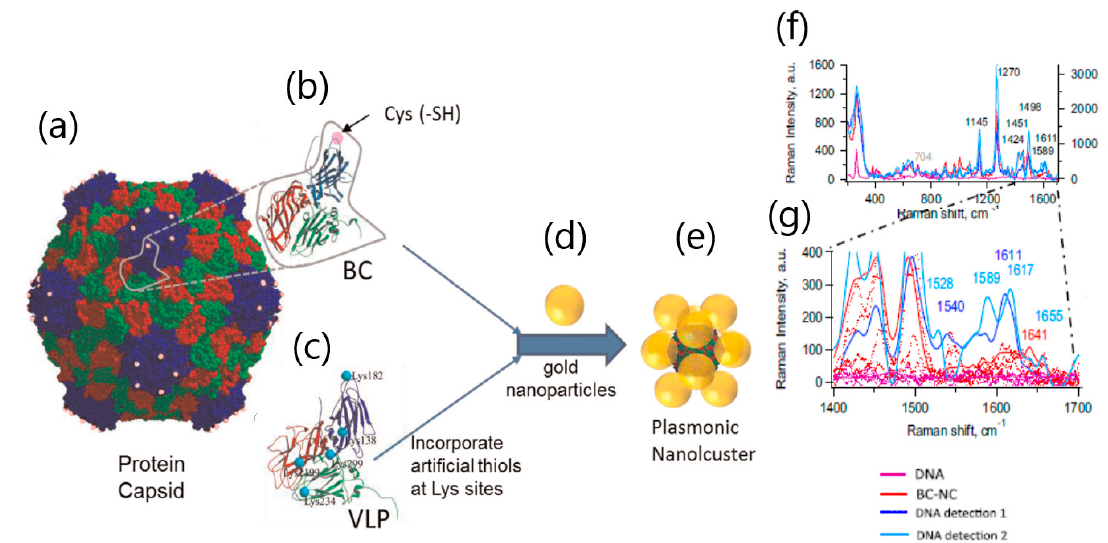
Figure 5. Plasmonic nanoclusters’ synthesis. ( a ) The protein capsid (30 nm in diameter) generated from ( b ) protein subunit where pink circles represent Cys incorporated via genetic engineering for a total of 60 thiols per capsid, basic cluster (BC)-mutant. ( c ) Protein subunit of the virus like particles (VLP) showing the locations of the naturally occurring Lys. ( d ) Gold nanoparticles (24–30 nm in diameter) were bound to the VLP or BC by directed self-assembly resulting in ( e ) plasmonic nanoclusters. ( f ) Detection of DNA by individual BC nanoclusters (NCs), averaged Raman spectra of plain DNA (violet), BC NC (red), and BC NC after addition of DNA (light and dark blue; DNA detections 1 and 2 were done individually in separate clusters). ( g ) Expanded area (1400–1700 cm − 1 ) with specific DNA Raman peaks. The characterization of NCs in solution showed a major peak of 78 nm and 77 nm for VLP-NC and BC NC, respectively, thus indicating that the size of the NC is larger relative to the free AuNP (major peak: 37 nm). Adapted with permission from Lebedev et al. [44] Copyright © (2016) Elsevier.